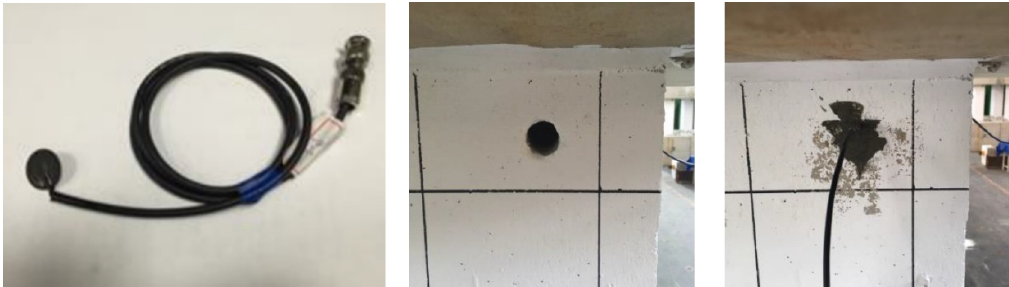
Figure 4. Piezoelectric sensor and the drilled and post-sealed bore hole.